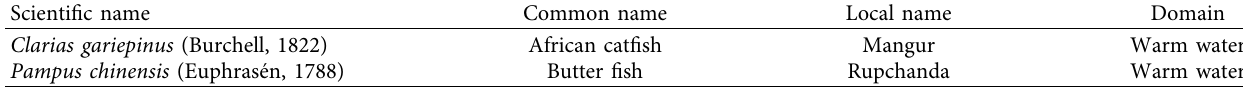
Table 4: Finfish species that are allowed to culture after taking legal authority in Nepal.